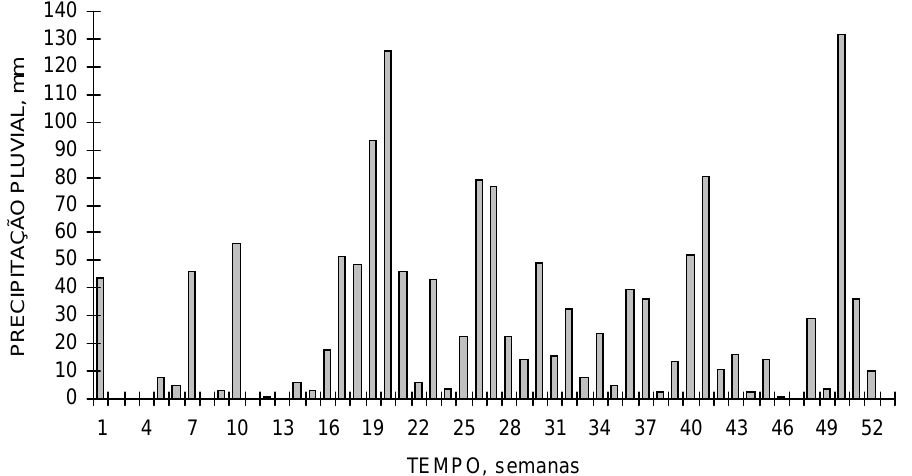
Figura 1. Precipitação pluvial semanal ocorrida na estação meteorológica do Centro Nacional de Pesquisa de Mandioca e Fruticultura Tropical (EMBRAPA), em Cruz das Almas (BA), durante o período de um ano, a partir de 11 de dezembro de